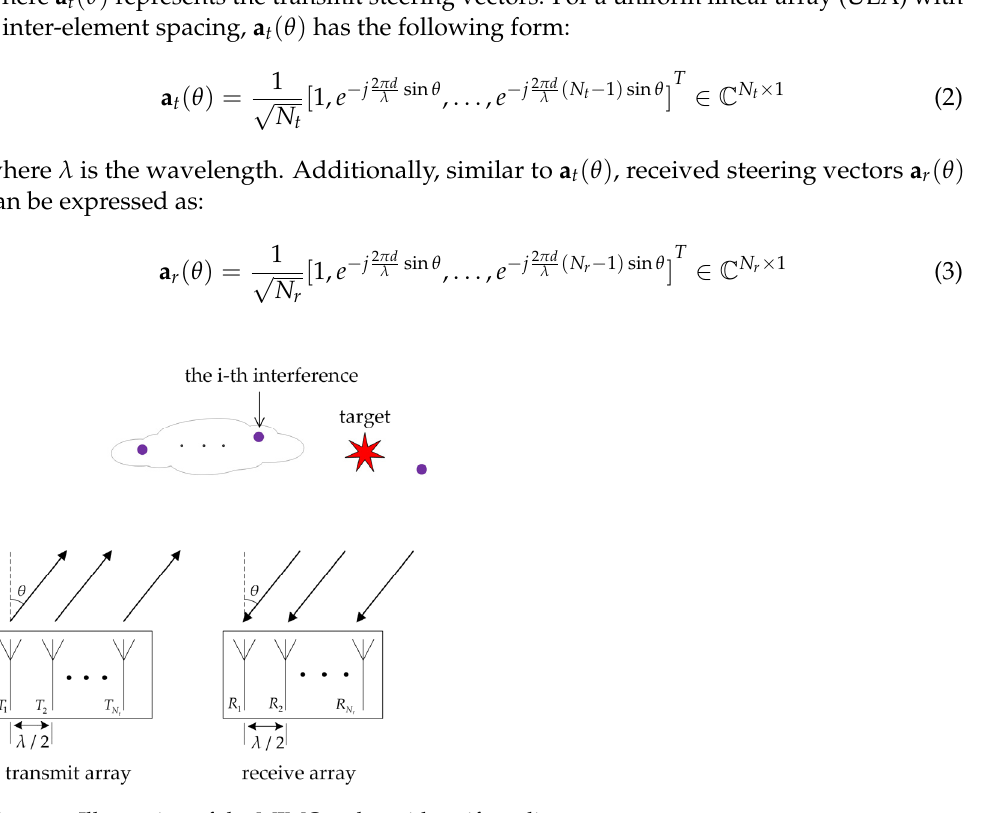
Figure 1. Illustration of the MIMO radar with uniform linear arrays.